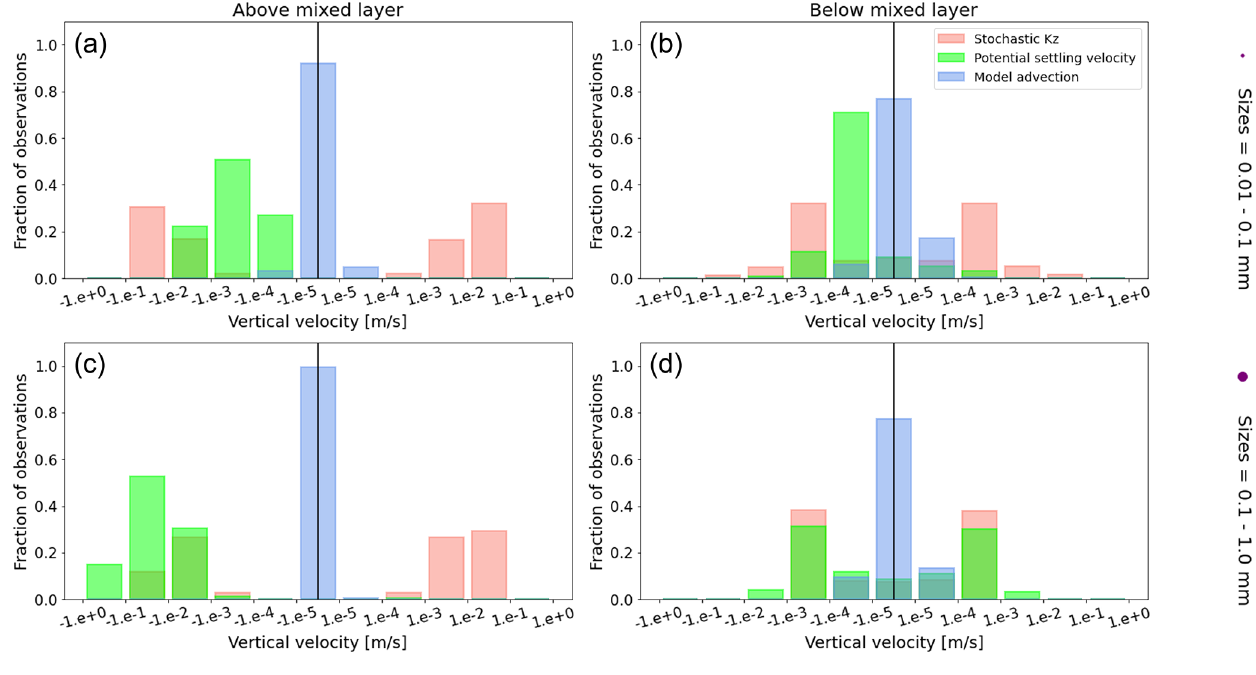
Figure A2. As in Fig. A1 but for the North Pacific Subtropical Gyre.